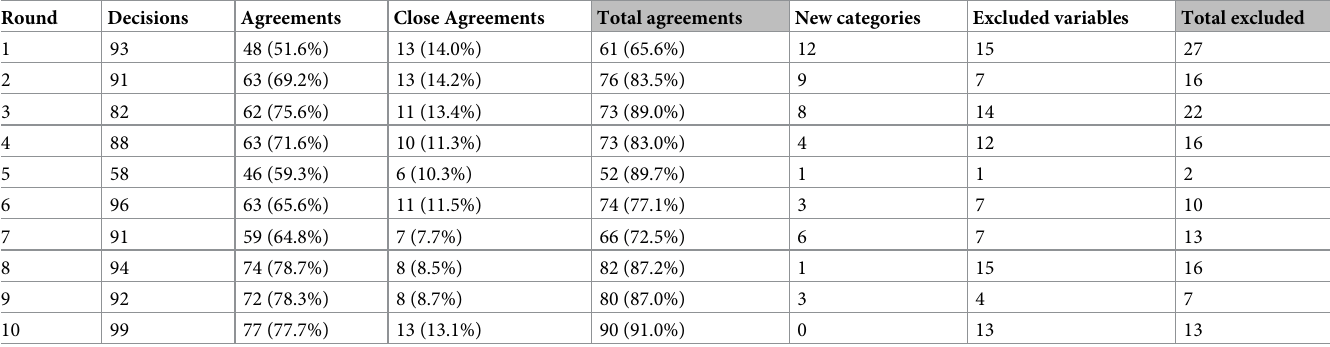
Table 1. Evaluation